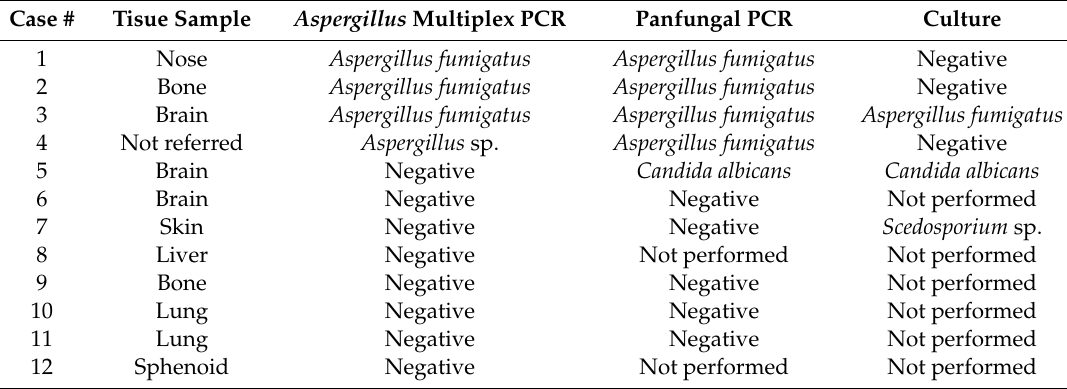
Table 1. Tissue samples analyzed using the Aspergillus multiplex PCR